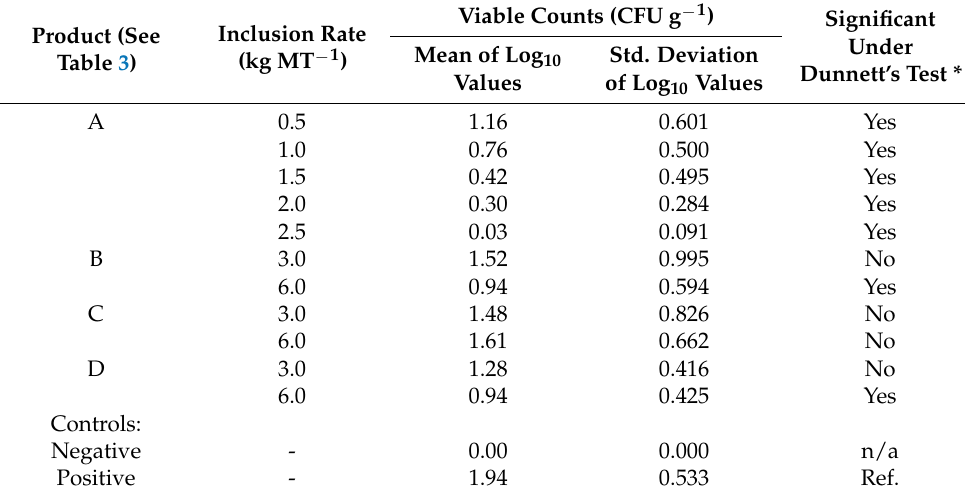
Table 4. Salmonella counts in product-treated feed 24 h after microbial challenge.